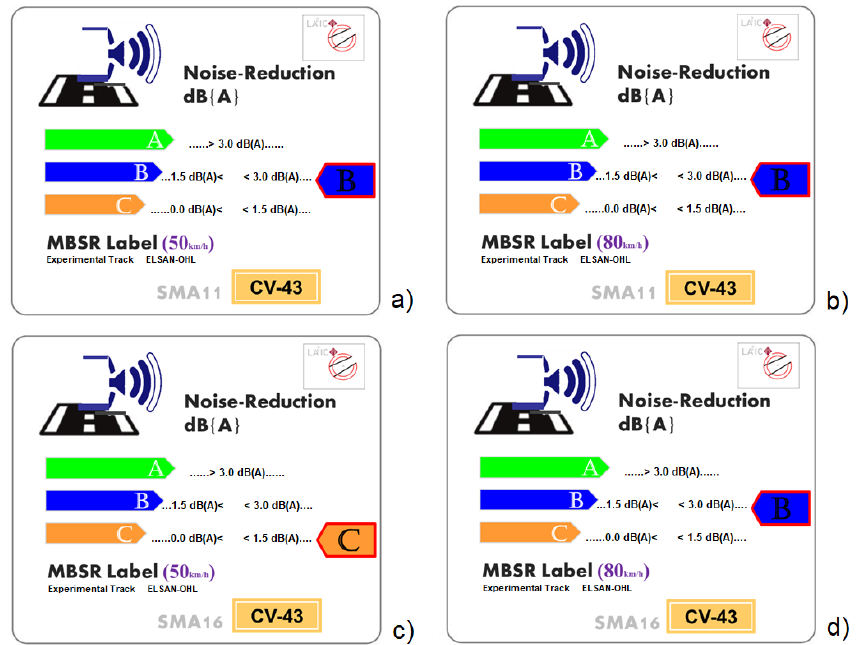
Figure 10. Acoustic labels according to the LNP labeling LA²IC methodology: ( a ) SMA11 at 50 km/h; ( b ) SMA11 at 80 km/h; ( c ) SMA16 at 50 km/h; and ( d ) SMA16 at 80 km/h.